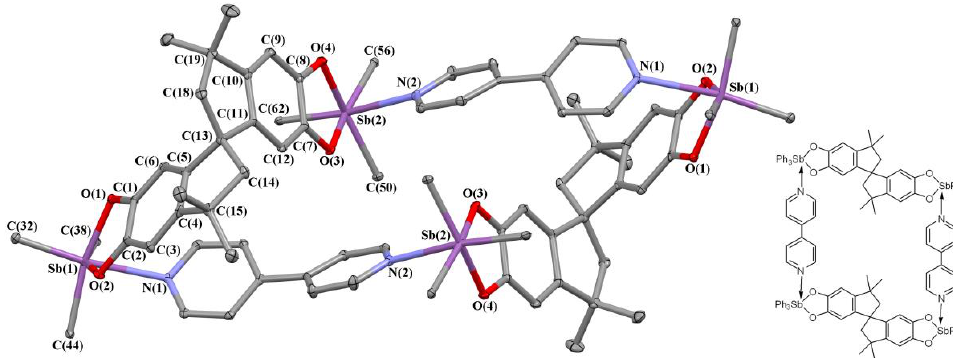
Figure 8. The X-ray structure of 13 . Thermal ellipsoids of 30% probability. The hydrogen atoms and carbons of phenyl groups (except atoms C(32), C(38), C(44), C(50), C(56), C(62)) are omitted. Antimony atoms Sb(1) and Sb(2) in 13 dispose in a distorted octahedral environ- ment. The chelate cycles at both antimony atoms are not planar: the bent angle of chelate cycle Sb(1)O(1)C(1)C(2)O(2) along O(1)...O(2) line is 13.50°, and the bent angle of chelate cycle Sb(2)O(3)C(7)C(8)O(4) along O(3)...O(4) line is 14.82°. The torsion angles O(1)C(1)C(2)O(2) and O(3)C(7)C(8)O(4) are 0.05 and 2.05°, respectively. The deviations of antimony atoms Sb(1) and Sb(2) from the octahedron basal planes are close (Sb(1)... plane O(1)O(2)C(38)C(44) is 0.269 Å , and Sb(2)... plane O(3)O(4)C(50)C(56) is 0.254 Å ). The O(1)C(1)C(2)O(2) is 0.80 ◦